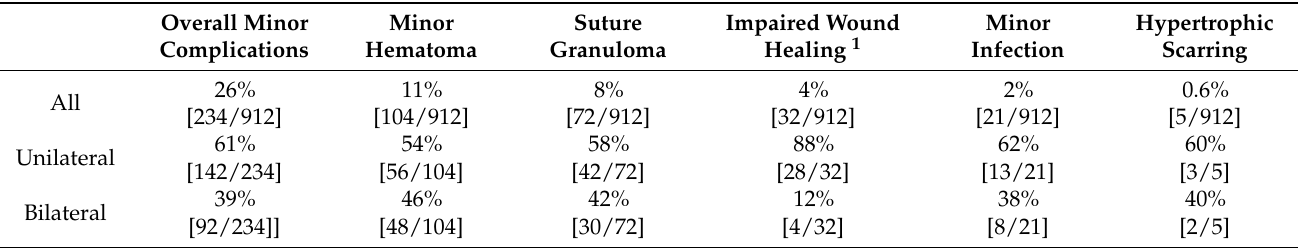
Table 2. Minor complications not requiring revision surgery following primary ventral otoplasty according to Lemperle technique ( n =